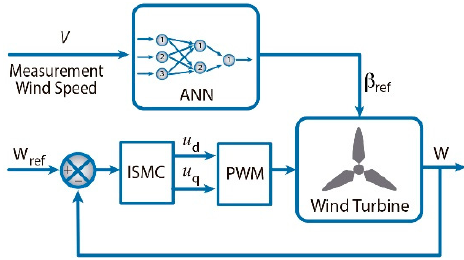
Figure 15. In the control strategy two techniques are used, Multy Layer Perceptron Neural Network (MLPNN) regulates the pitch angle and Integral Sliding Mode Control (ISMC) adjusts the rotor speed reference independently of external disturbances [72].